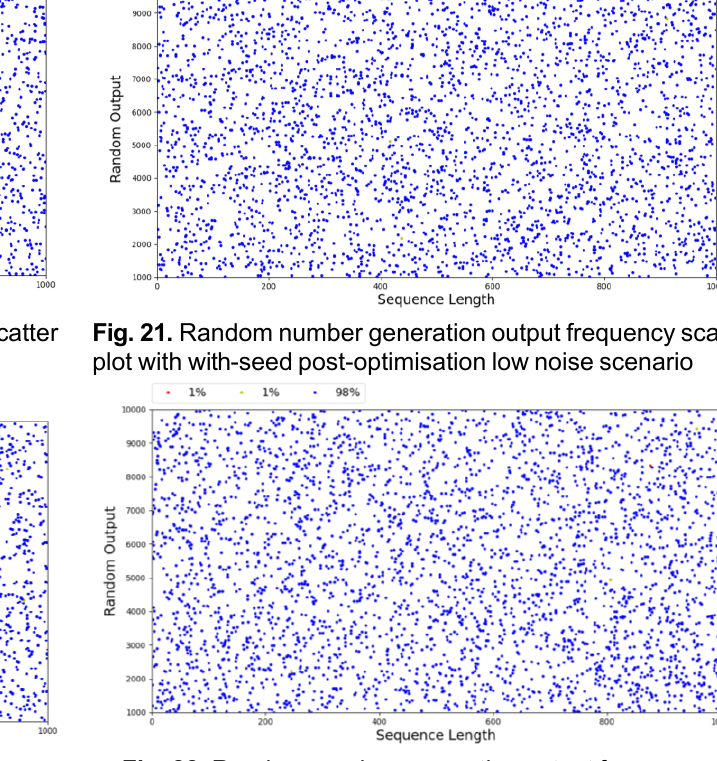
Fig. 22. Random number generation output frequency scatter plot with with-seed post-optimisation high